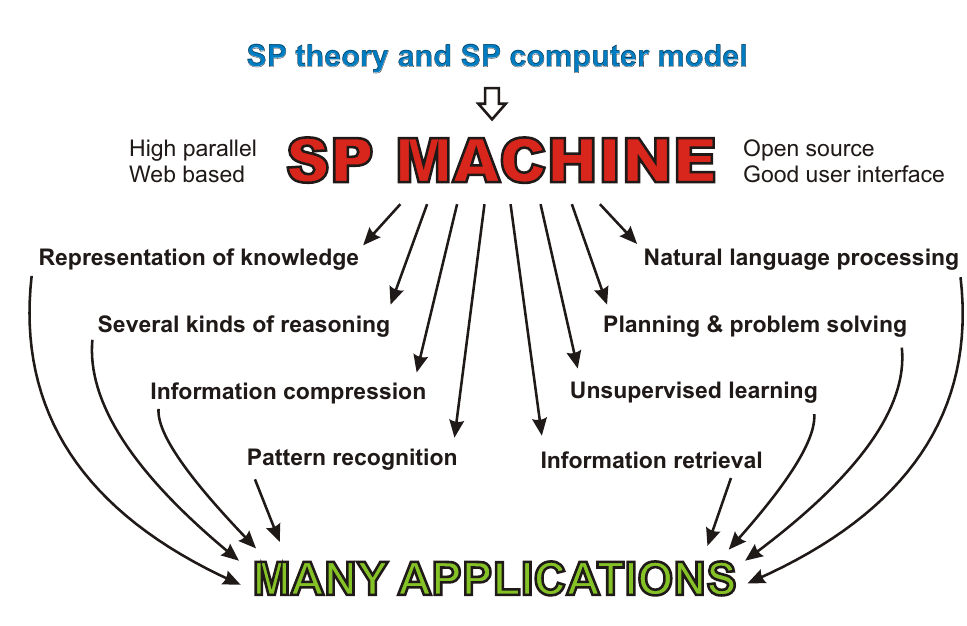
Figure 2. Schematic representation of the development and application of the proposed SP machine. Reproduced with permission from Figure 2 in